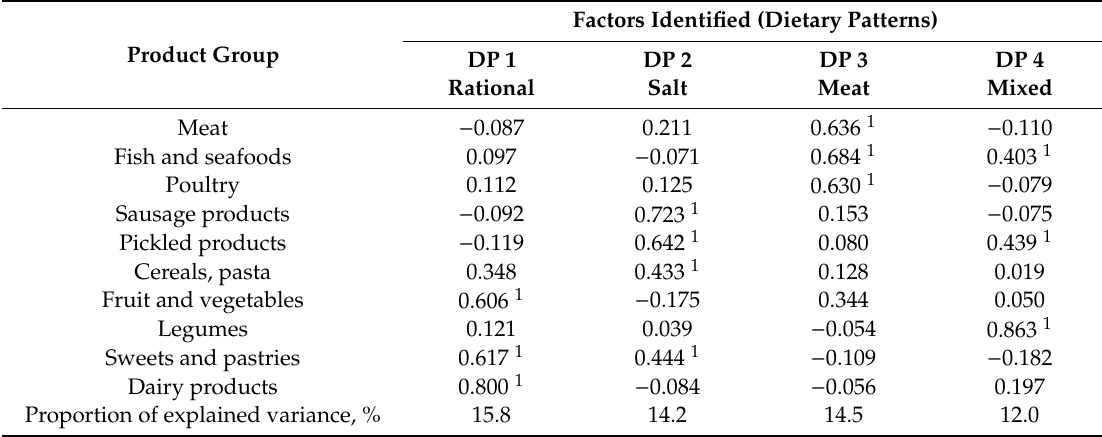
Table A5. Factor loadings of the principal dietary patterns identified (45–54 years).